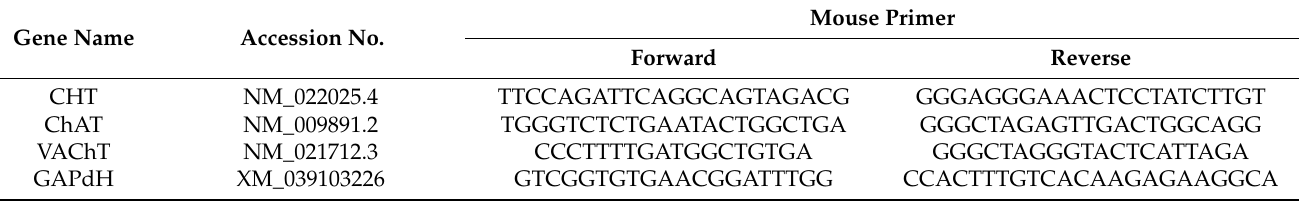
Table 1. Sequences of the primers used in the current